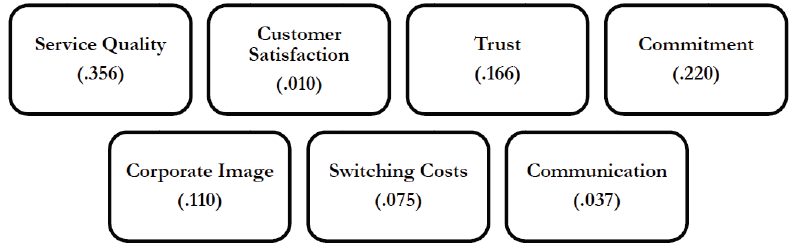
Fig. 3 - Relative Weights of Antecedents. Source: own elaboration.